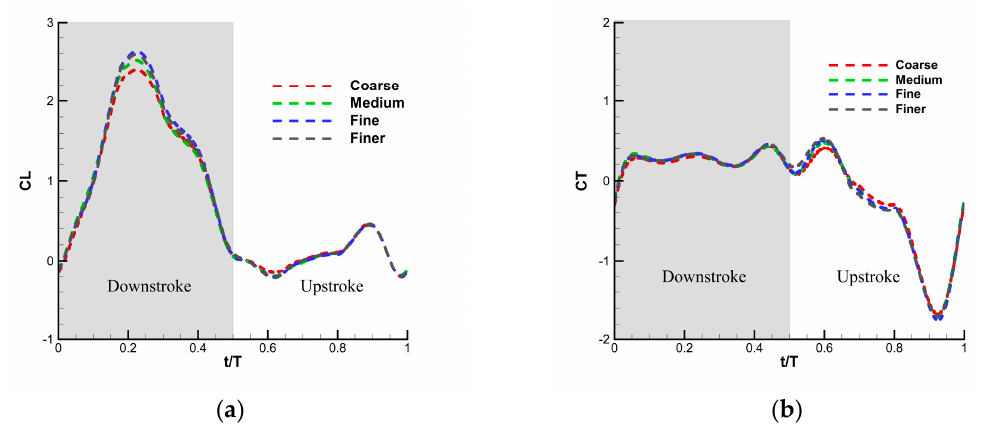
Figure 6. Mesh grid (fine) and motion parameters for the simulation of a dragonfly hindwing during hovering motion in the initial time step. ( a ) Flapping motion parameters in the initial time step; ( b ) grid of computational flow field in the initial time step.